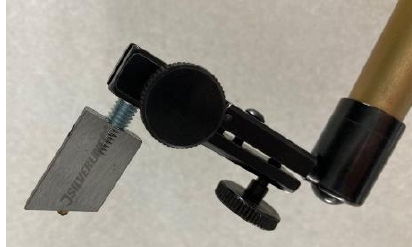
Fig. 1. Photograph of the diamond scribe before an experiment. The use of a dial gauge stand allows to compensate small heigh variations of the glass surface and achieves a constant pressure by a prestressing of the